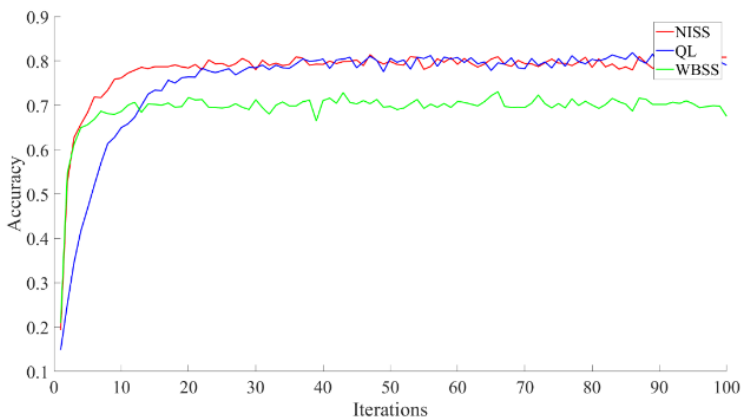
Figure 8. Decision accuracy of three anti-intelligent blocking jamming algorithms. As can be seen from Figure 8, since the intelligent blocking jamming interferes with different channels in each time slot with probability, it is impossible to fully predict the jamming channel of the next time slot. Therefore, even with Q-learning, the decision accuracy is only